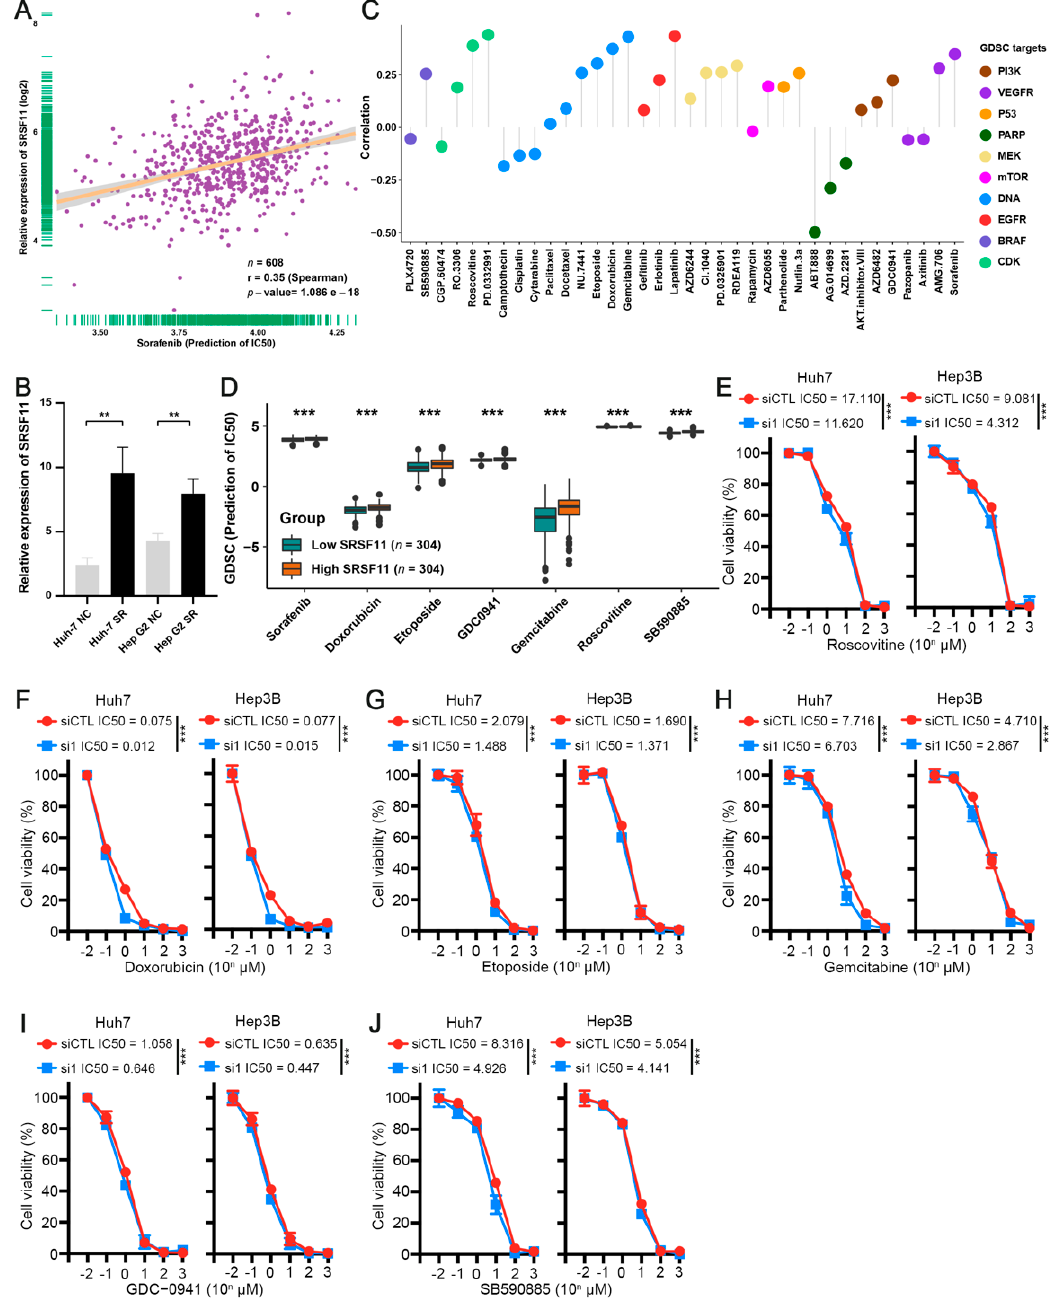
Figure 9. Silencing of SRSF11 improves drug sensitivity to systemic therapy in HCC. ( A ) Correlation analysis between SRSF11 expression and the predicted IC50 of sorafenib. ( B ) The relative expression of SRSF11 mRNA in parental HCC cells and corresponding sorafenib-resistant (SR) HCC cells. ( C ) Correlation analysis between SRSF11 expression and predicted IC50 values for the indicated inhibitors from the GDSC database. ( D ) Predicted IC50 values for the indicated inhibitors are stratified by the SRSF score. ( E – J ) CCK-8 assays for Huh7 or Hep3B cells transfected with siSRSF11 and siCTL, respectively, and treated with a range of concentrations of the indicated inhibitors for 3 days. The results are presented as the means ± SDs, and three independent experiments ( N = 3) were performed in triplicate. Student’s t -test was used for statistics. The asterisks represent the statistical p -value (** p < 0.01 and *** p <